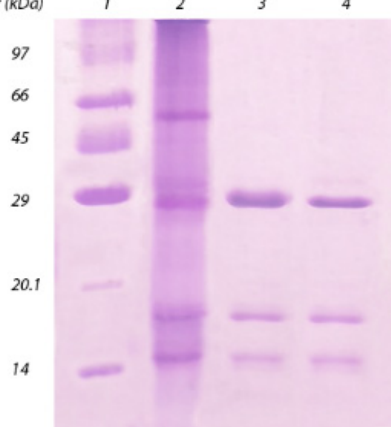
Figure 2. SDS-PAGE. Lane 1: molecular mass markers (phosphorylase b, 97 kDa; bovine serum albumin, 66 kDa; ovalbumin, 45 kDa; carbonic anhydrase, 29 kDa; trypsin inhibitor, 20.1 kDa; and α -lactalbumin, 14 kDa); lane 2: crude extract; lane 3: DlyL (30 µg); lane 4: DlyL (30 µg) with 2% β